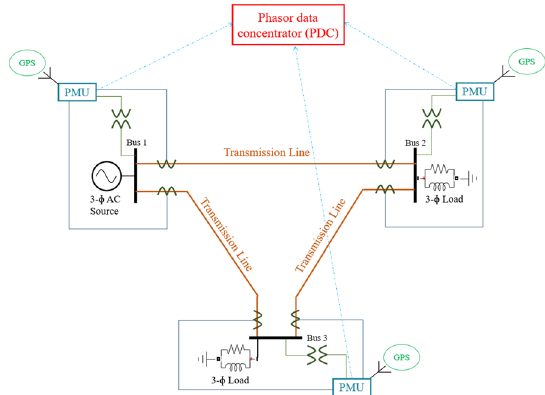
Fig. 5 Single line diagram of three-bus